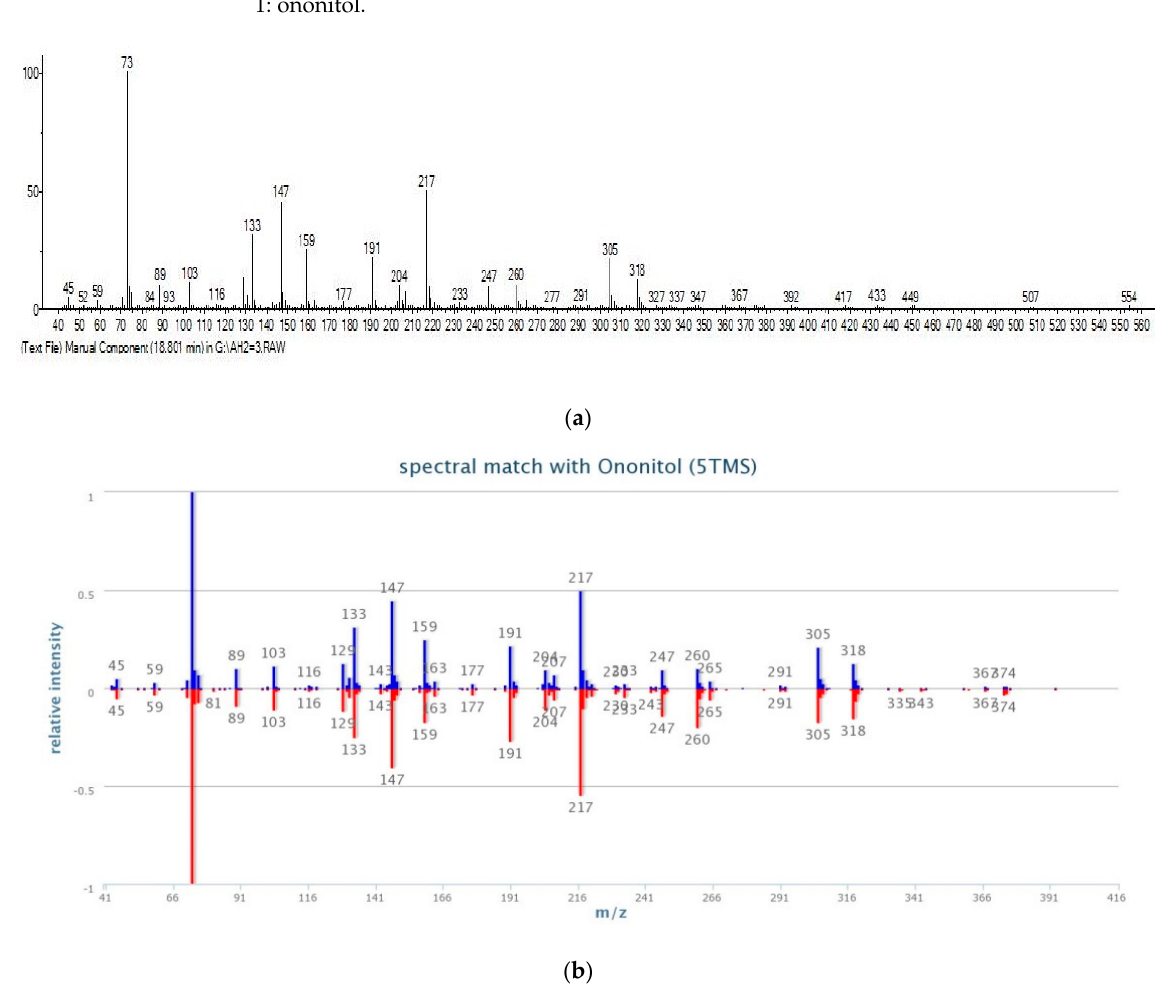
Figure 2. GC/MS spectra of ( a ) derivatized ononitol of methanolic extract, and ( b ) ononitol from the extract and MS spectra of standard of Golm Metabolome Database (GMD).